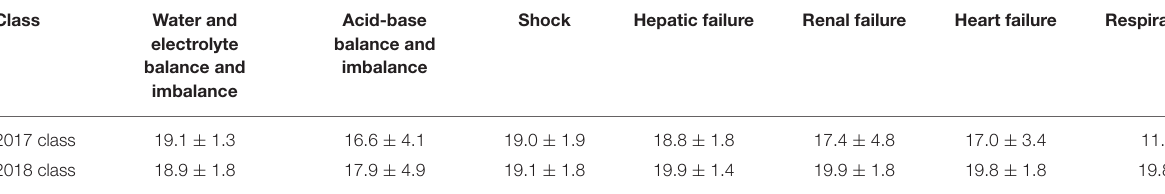
TABLE 1 | Mean scores of pre-class quizzes in 2017 and 2018 classes (total 20 points).